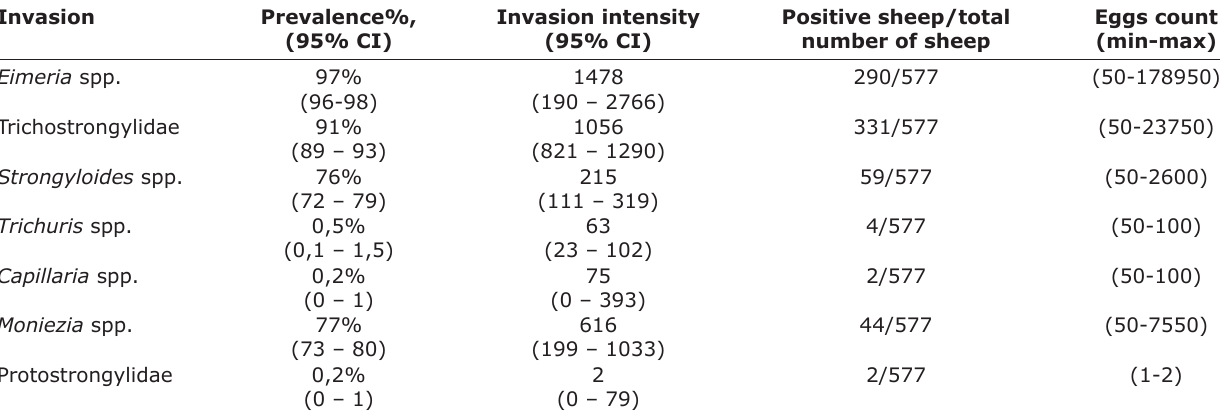
Invasion intensity (95% CI) (95% CI)